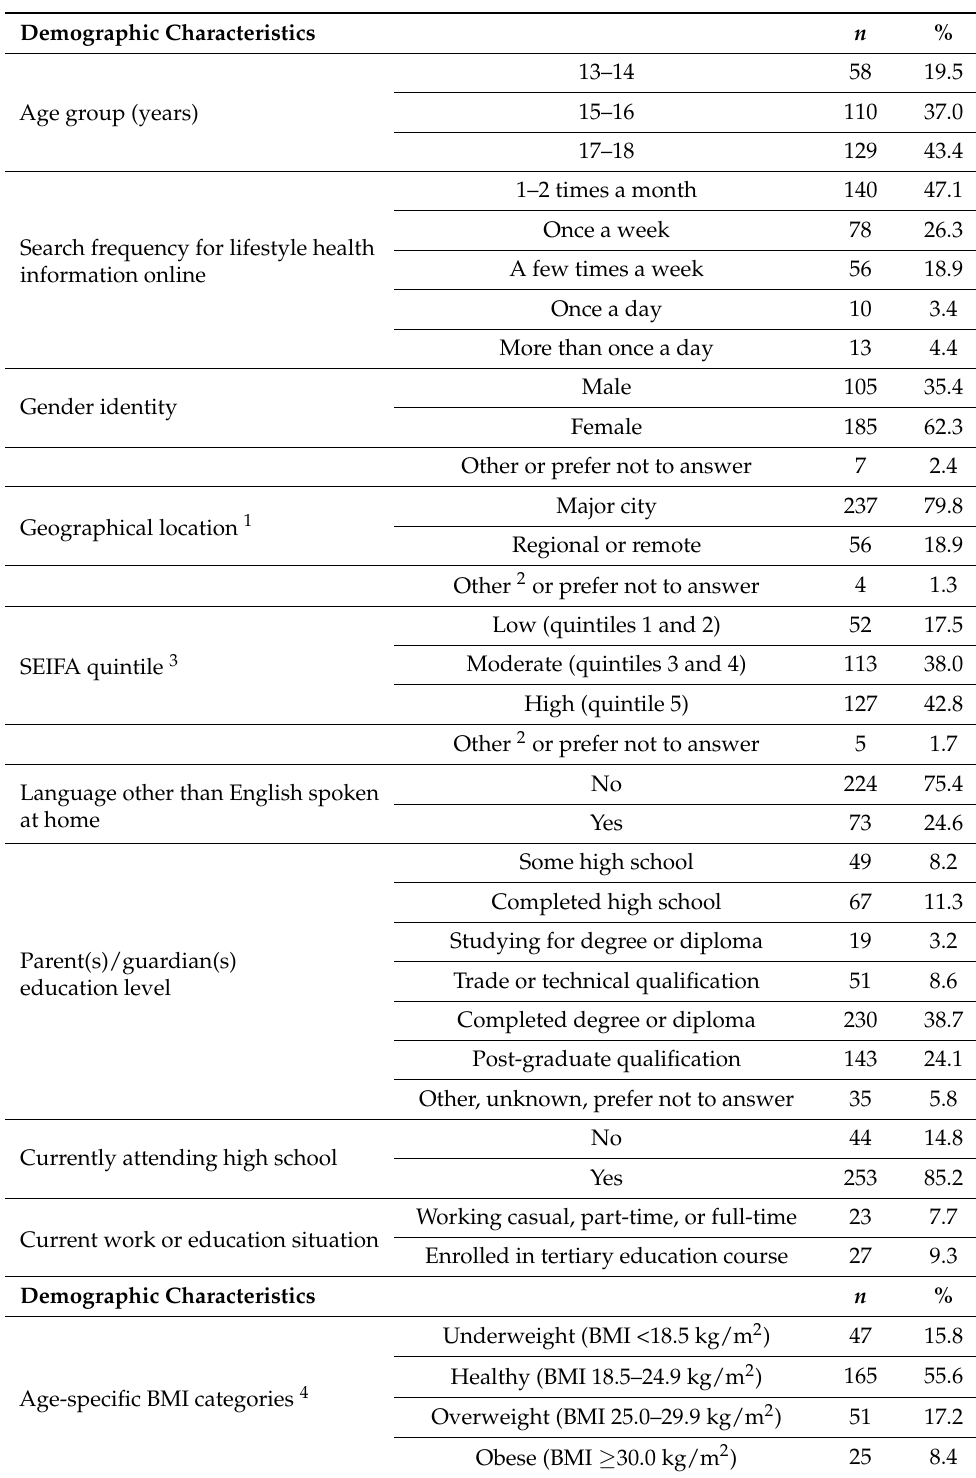
Table 1. Demographic characteristics, healthy lifestyle behaviours and internet access, electronic devices, and digital platforms of participants ( n =